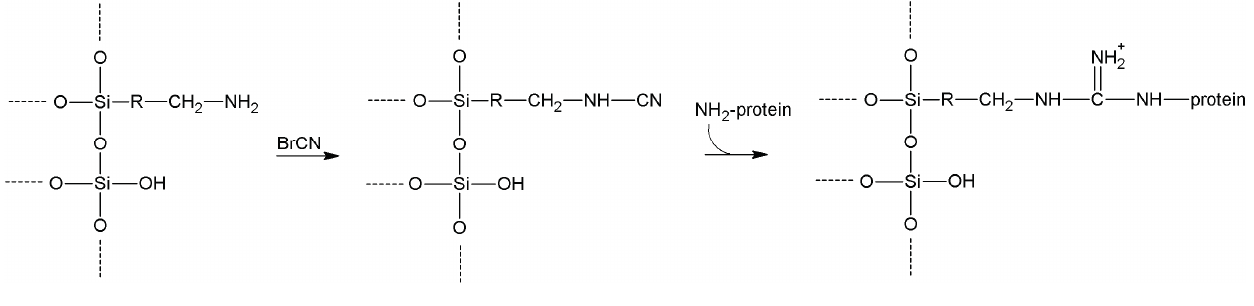
Figure 4. 4-Nitrophenyl cyanate, N -cyanotriethylammonium bromide, and 1-cyano-4-dimethylaminopyridinium bromide have been described as effective cyanylating agents in alternative to BrCN